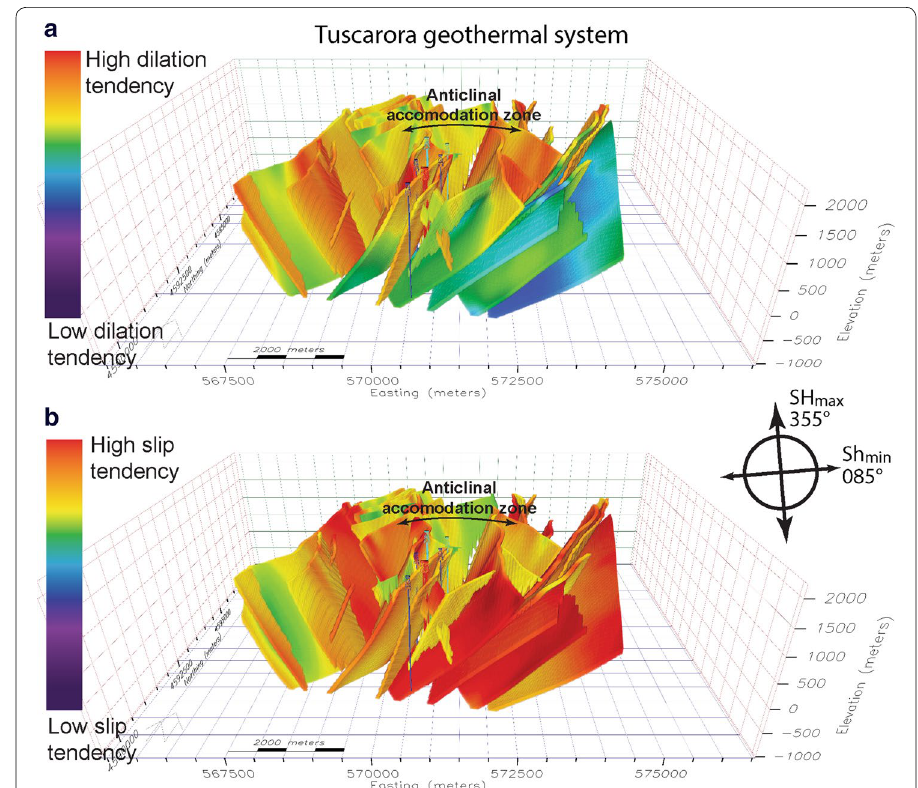
Fig. 9 Dilation ( a ) and slip ( b ) tendencies calculated for the 3D mapped fault system at Tuscarora. Warm colors represent a high potential for that part of a fault zone to be critically stressed and are therefore more likely to conduct fluids relative to other fault segments. Cool colors indicate that the resolved stresses on the fault surface are relatively low, and therefore the fault is not critically stressed and has less potential to conduct fluids. The modeled horizontal stress field, based on inversion of fault kinematic data (Dering 2013), is shown, the maximum stress is